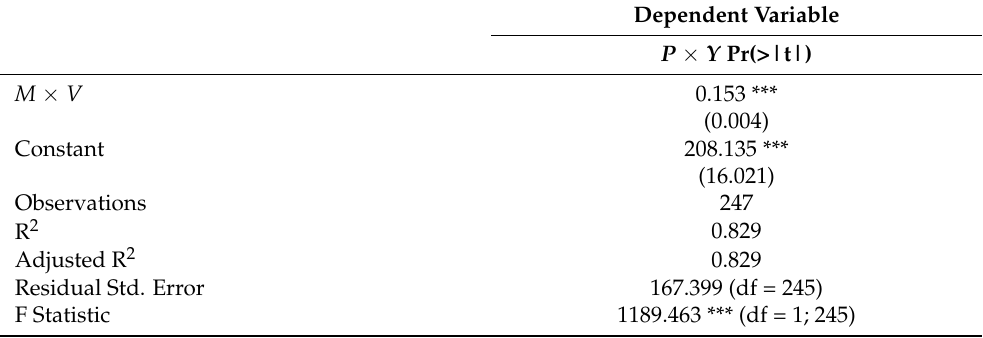
Table 7. Demand side estimation.